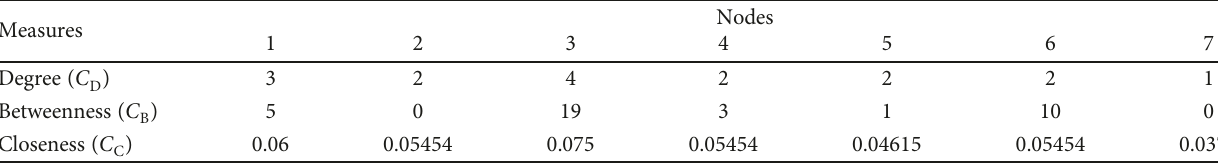
Table 1: Three typical measures of node in fl uences.